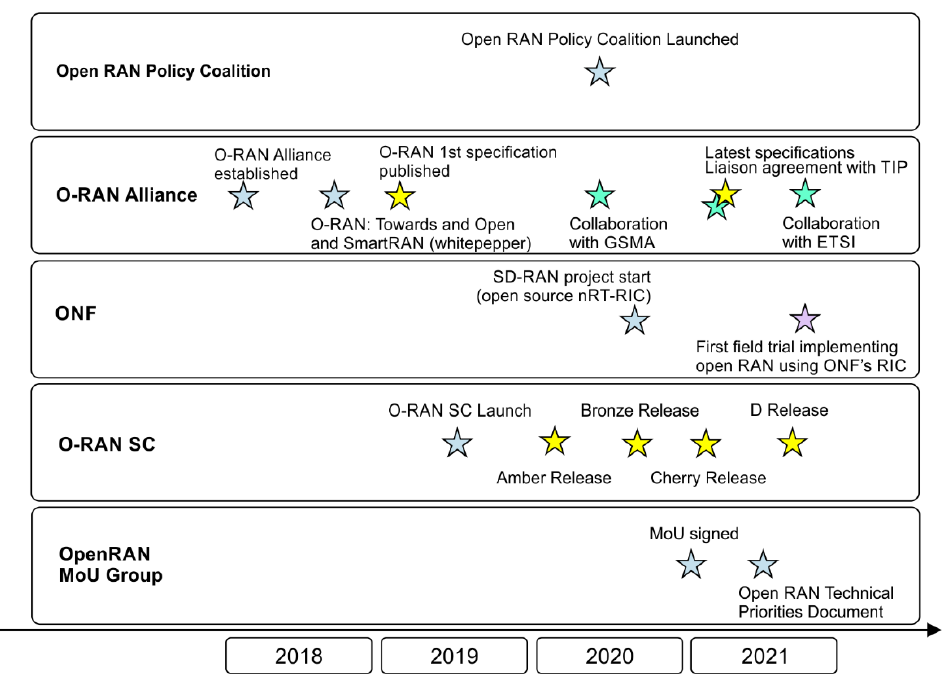
Figure 4. Timeline of selected actions and events related to Open RAN development.